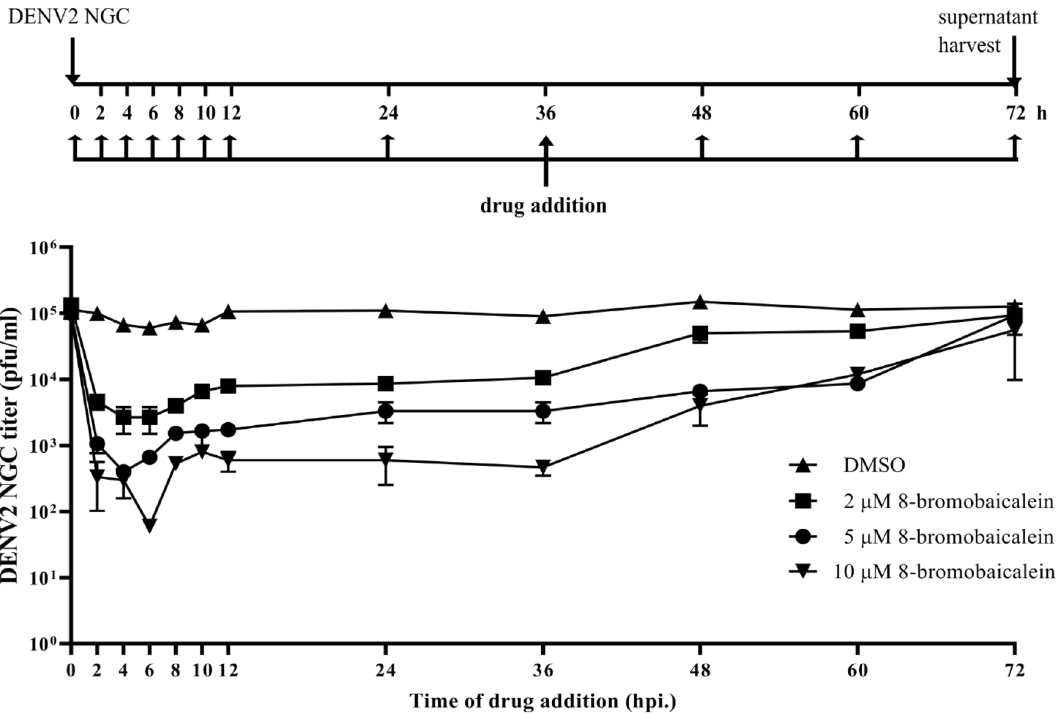
Figure 5. A scheme and DENV2 titers (pfu/ml) in LLC/MK2 cells of time-of-drug addition study. Briefly, the 2, 5, and 10 µM 8-bromobaicalein was added into DENV2-infected cells (M.O.I. of 0.1) at various time points. All supermatants were harvested at 72 h and quantified by plaque assay. Errors indicated the standard deviation of three biological (Fig. 6C). The effect was completely reversible at the 3rd and the 8th days 49 . This finding was similar to bromi-